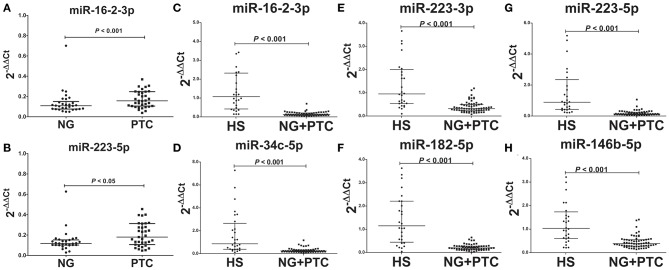
Expression levels of the selected plasma exosomal miRNA candidates in the validation set. Plasma exosomal miRNA was isolated from 30 benign thyroid nodules, 35 PTC cases, and 31 healthy controls. A total of 4 ng of miRNA was reverse transcribed using a QIAGEN miScript II RT kit. After 1:10 dilution, 2 μL of cDNA template was used for quantification by real-time PCR. Plasma levels of exosomal (A) miR-16-2-3p (p < 0.001) and (B) miR-223-5p (p < 0.05) were significantly higher in PTC compared with benign thyroid nodules. Levels of exosomal (C) miR-16-2-3p (p < 0.001), (D) miR-223-5p (p < 0.001), (E) miR-34c-5p (p < 0.001), (F) miR-182-5p (p < 0.001), (G) miR-223-3p (p < 0.001), and (H) miR-146b-5p (p < 0.001) were significantly lower in benign thyroid nodules and PTC compared with healthy subjects (HS). MiR-30e-5p was used as an internal control. The relative difference between the groups was calculated as 2−ΔΔCt. Horizontal lines: median with interquartile range.